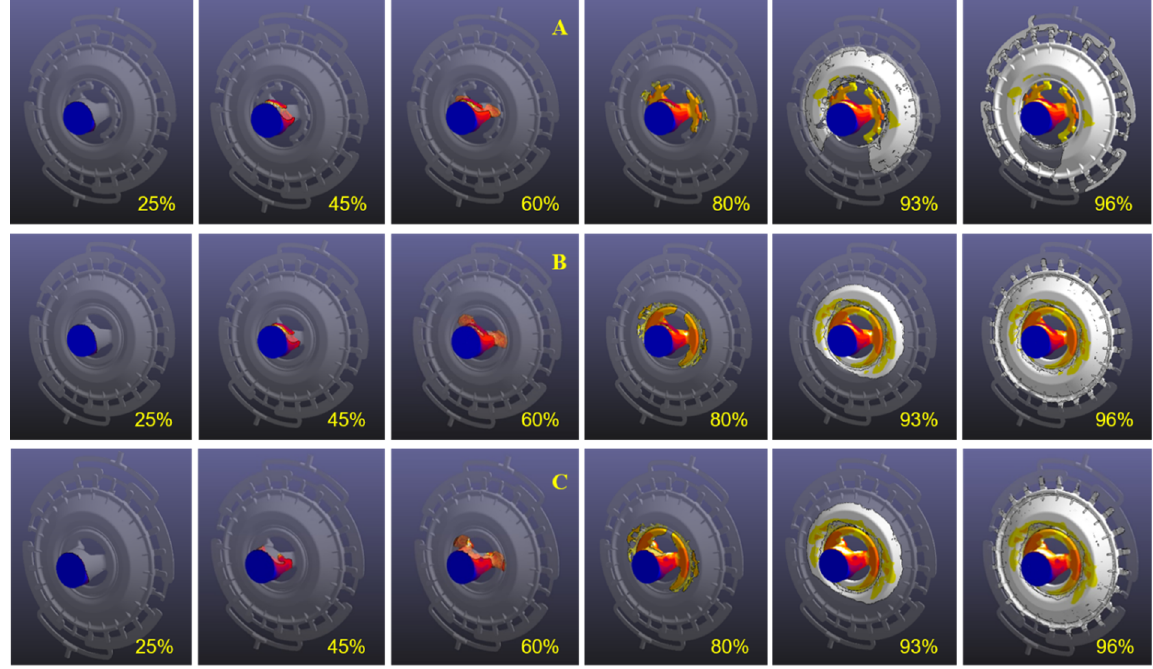
Figure 3. Simulation results of the melt filling process: ( A ) Case 1; ( B ) Case 2; ( C ) Case 3.